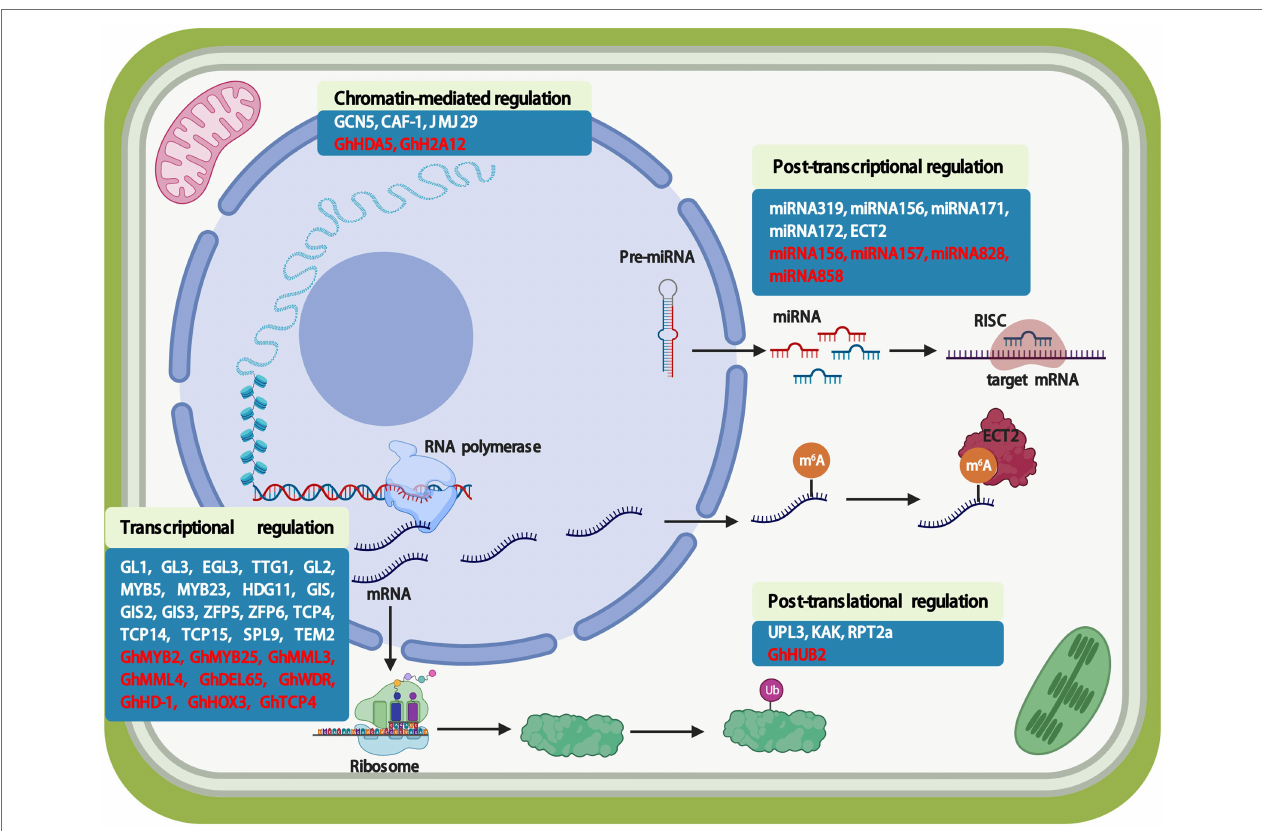
FIGURE 2 | Multi-dimensional regulation of Arabidopsis trichome and cotton fiber development. The control of trichome and fiber development involves multi- dimensional regulation. Here shows chromatin-mediated, transcriptional, post-transcriptional, and post-translational regulation modes. Chromatin-mediated regulation of trichome and fiber development, including histone modification and maintenance of chromatin states. Multiple transcription factors are involved in trichome and fiber development. The post-transcriptional regulation of trichome and fiber development is mainly caused by miRNA. Post-translational modifications, such as ubiquitination, is important in regulating trichome and fiber development. White words represent the genes are involved in trichome-related genes in Arabidopsis ; Red words represents the genes are involved in cotton fiber development. Pre-miRNA: premature microRNA; m 6 A: N 6 -methyladenosine; RISC: RNA- induced silencing complex; Ub: